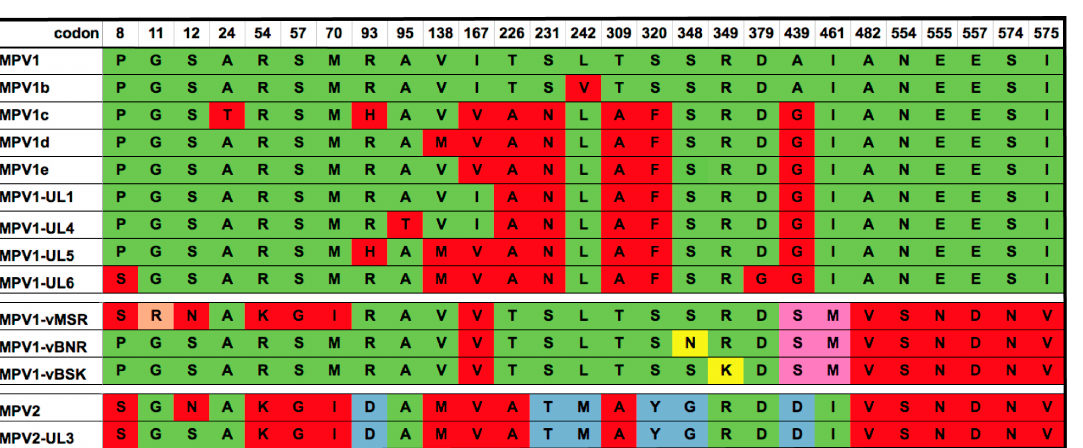
Figure 6. Alignment of MPV1 and MPV2 VP2 sequences. VP2 amino acids that conform to the MVP1 GenBank sequence are shaded green, and those within the MPV1 sequences that differ from this are shaded red. One residue, at codon 11, is unique to the parental pool, and is shaded orange. Amino acids that are unique to the parental pool and invariant in the selected virus clones are shaded lilac, and those unique to subsets of the selected viruses are shaded yellow. Residues that are unique to MPV2 are shaded blue. GenBank accession numbers are reported in the Methods.